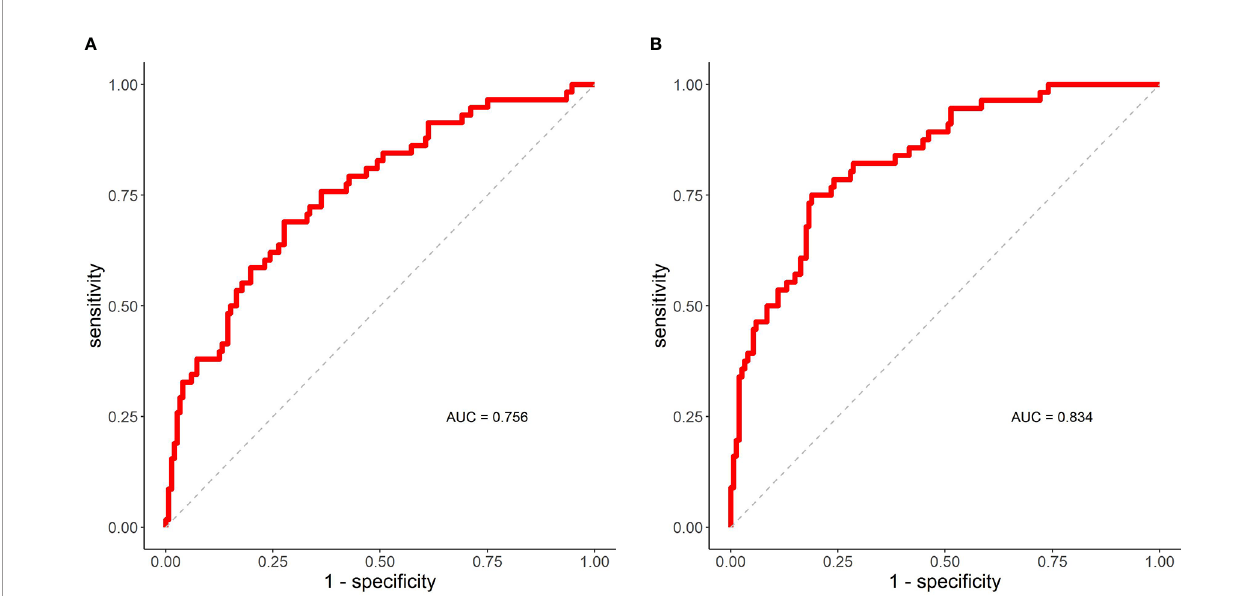
FIGURE 3 | ROC curves and AUC. (A) The ROC curve and AUC of DSC (IGTV-MIP, IGTV-10) prediction model. (B) The ROC curve and AUC of DSC (IGTV-CBCT, IGTV-10) prediction model. AUC, area under the curve; DSC, Dice ’ s similarity coef fi cient; IGTV-10 indicates internal gross target volume from 10 phases of four- dimensional computed tomography; IGTV-CBCT, internal gross target volume-cone beam computed tomography; IGTV-MIP, internal gross target volume maximum intensity projection; ROC, receiver operating